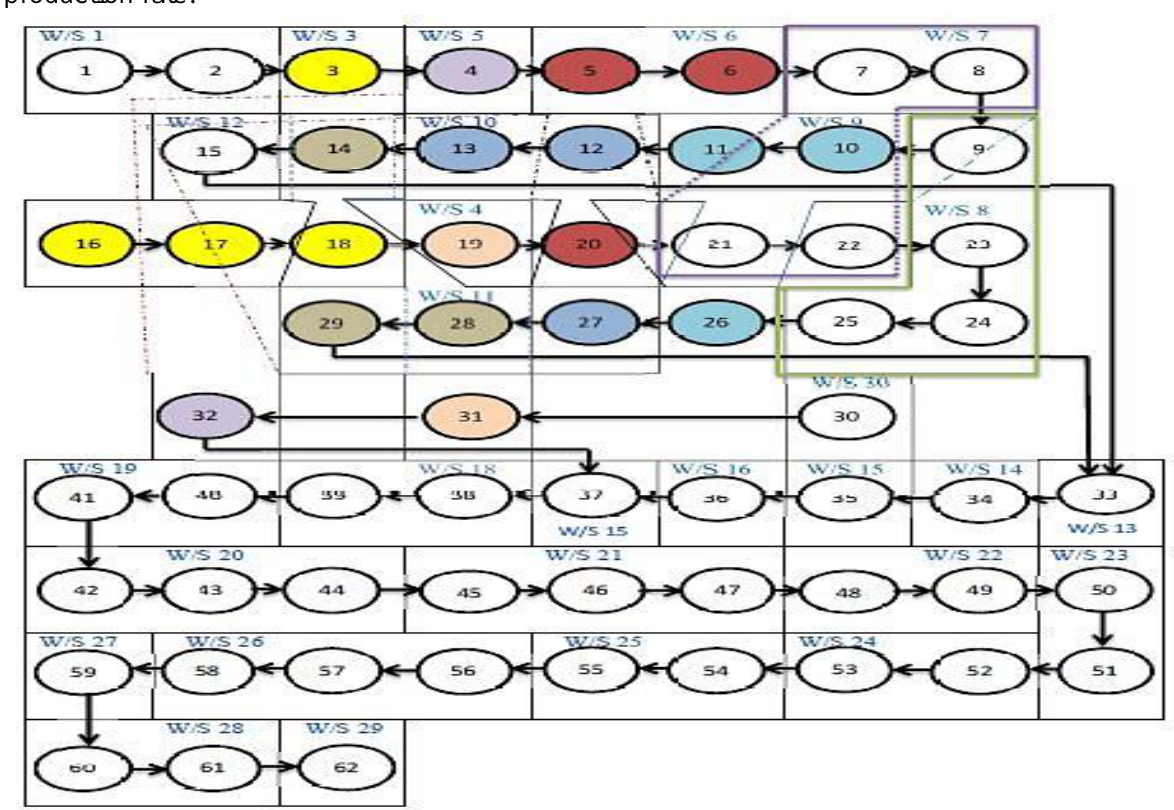
Figure 4. Assignment of work element according to Kilbridge & Wester